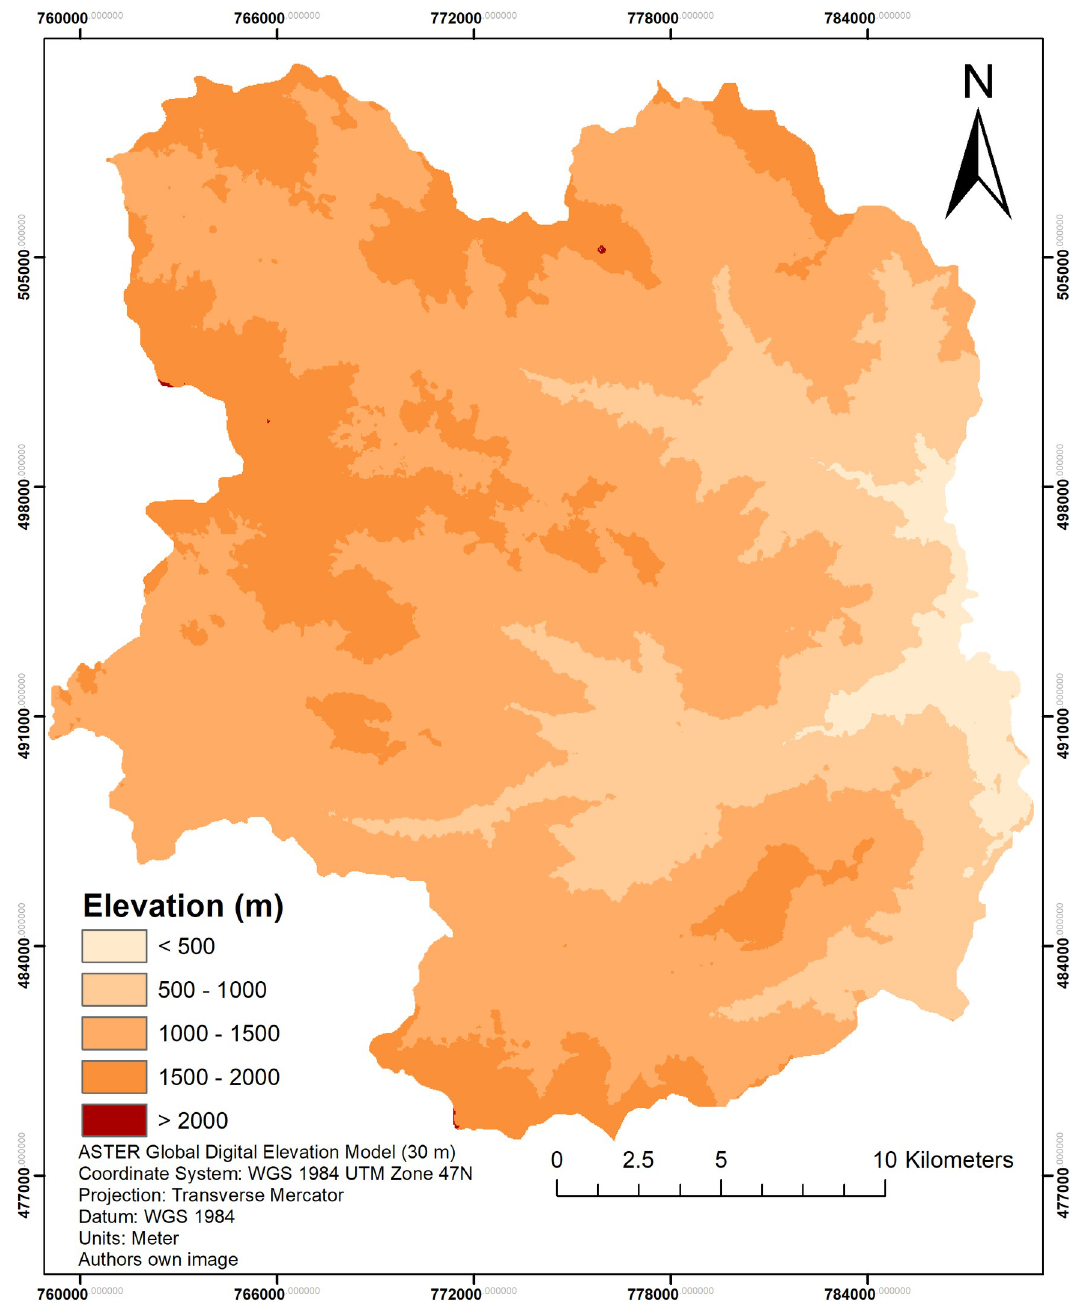
Fig 3. Elevation map of Cameron Highlands. (Data source: ASTER Global Digital Elevation Model courtesy of NASA Earth Data).